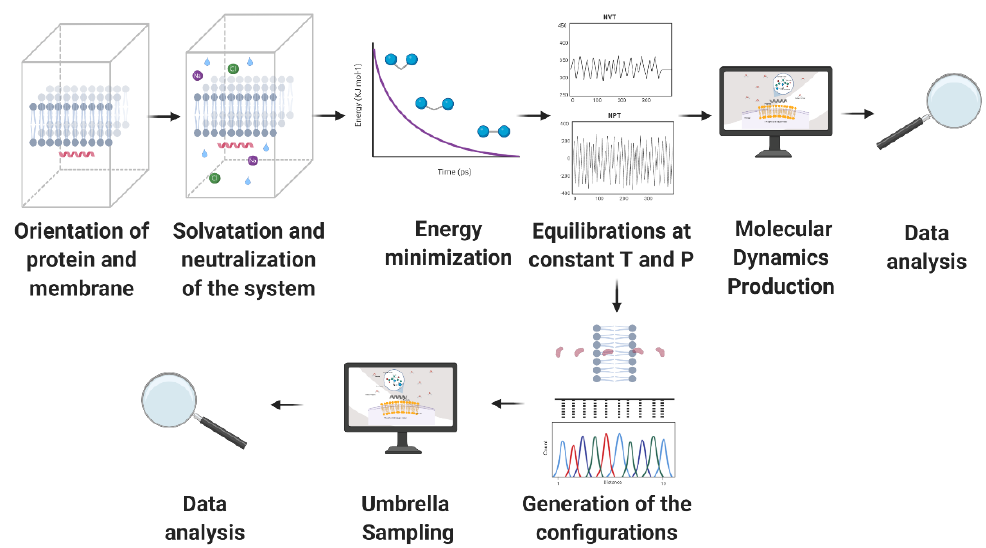
Figure 5. Schematic representation of a classic molecular dynamics simulation (MD) process. Initially, a preparation stage is required in which the system is assembled. Subsequently, the position restraints are turned off to run the MD simulation, and finally, the data of the trajectories are obtained and analyzed (Created with BioRender).